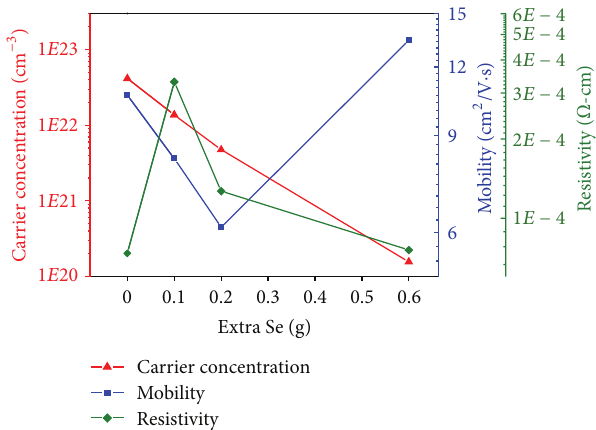
Figure8:Resistivity( 𝜌 ),hallmobility( 𝜇 ),andcarrierconcentration ( 𝑛 ) of the CIS absorber layers as a function of extra Se content; the selenization temperature was 550 ∘